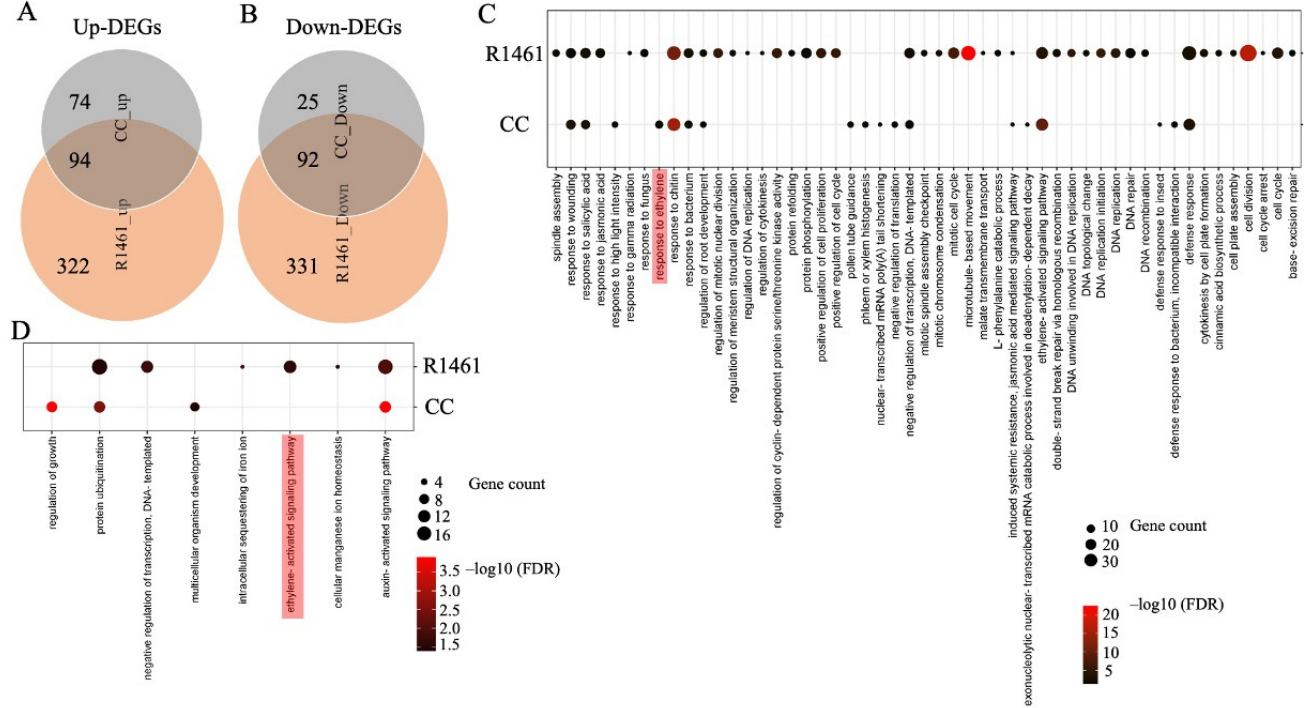
Figure 2. Analysis of chilling ‐ induced differentially expressed genes (DEGs) and their enriched Biological Process (BP) GO terms in CC and R1461. ( A ) Venn diagram analysis of the up ‐ regulated DEGs and down ‐ regulated DEGs ( B ) in CC and R1461 under chilling treatment. The DEGs were identified from chilling versus non ‐ chilling with |log 2 FC| ≥ 1, FDR ≤ 0.05. A dot bubble diagram is presented for enriched BP terms in up ‐ regulated DEGs ( C ) and down ‐ regulated DEGs ( D ) in CC and R1461 under chilling treatment. Significant enrichment of BP terms was established with FDR ≤ 0.05. The x ‐ axis represents the enriched BP terms, and the y ‐ axis indicates the CC and R1461.